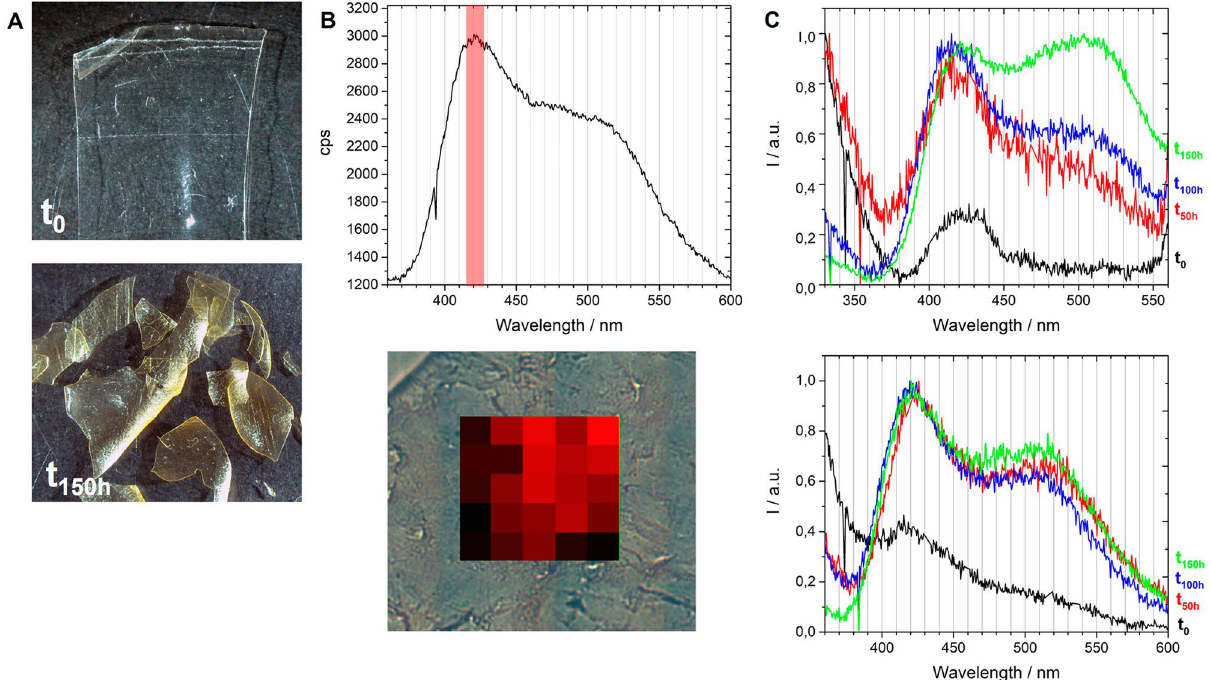
Figure 5. ( A ) Microscope images (7.1 × magnification) of cellulose nitrate homogeneous thin films (150 µm) used as reference films before (t 0 ) and after 150 h of irradiation. ( B ) POLYPHEME raster scanning map of a 150 h aged celluloid reference (λ exc = 330 nm, 20 µm step, 5 s acquisition time), together with the average, representative, emission spectrum. Intensity variations of the probed region between 415 and 425 nm are due to the topography of the sample. ( C ) Normalized emission spectra of artificially aged cellulose nitrate (top, λ exc = 290 nm) and celluloid (bottom, λ exc = 330 nm) irradiated during 50 h, 100 h and 150